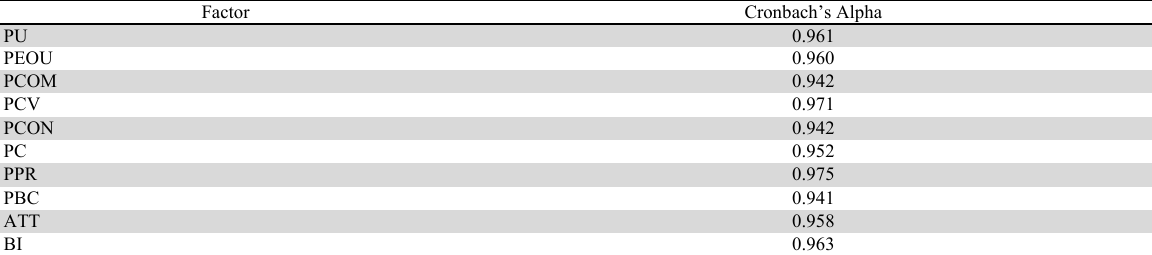
Reliability of Pilot Test Questionnaire